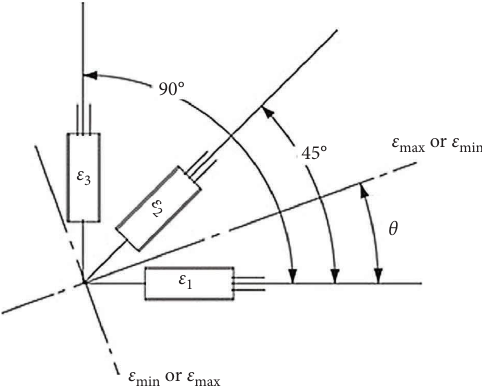
Figure 3: Triaxial rosette piezoelectric strain sensor arrangement